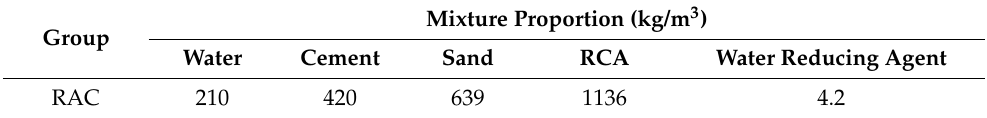
Figure 5. Gradation curve of RCA. Table 1. Mixture prepositions of RAC.